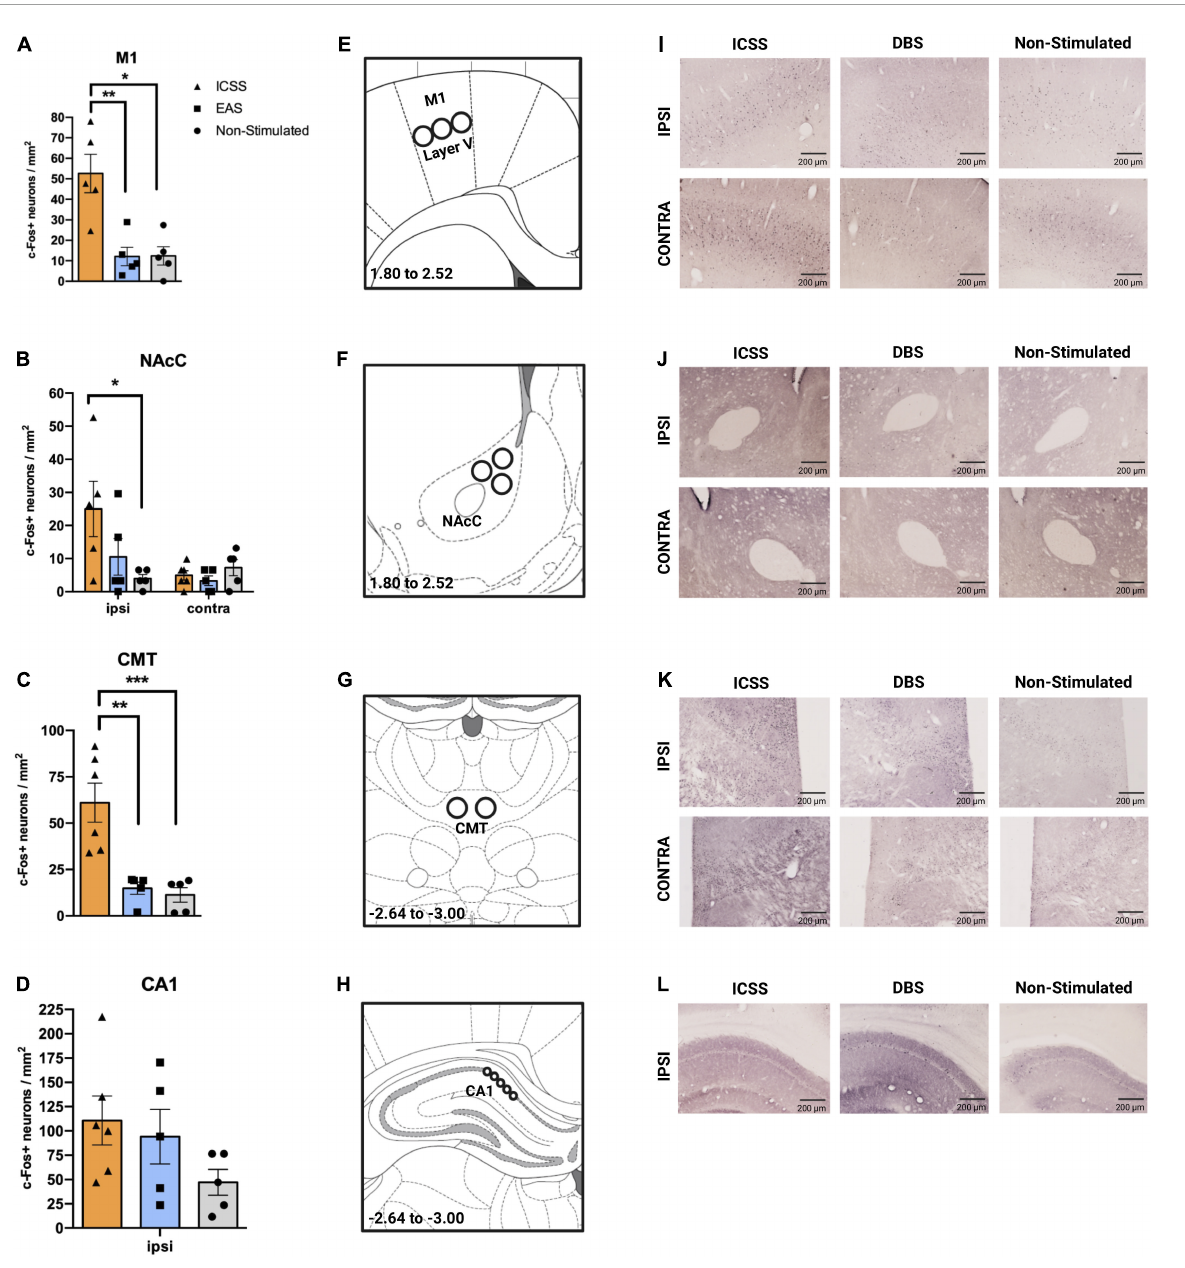
FIGURE10 Effects of different administrations (self-administered or experimenter-administered) on c-Fos expression in the primary motor cortex, nucleus accumbens core, centromedial thalamus, and CA1. (A–D) c-Fos + neurons/mm 2 ( ± SE) in the (A) primary motor cortex (M1), (B) NAcC, (C) CMT, and (D) CA1. The ipsilateral hemisphere corresponds to the right hemisphere, in which the electrode was implanted. Panels (A,C) show the mean expression of c-Fos of both hemispheres. (E–H) Regions of interest (ROI) for the quantification of c-Fos + neurons of the (E) M1, (F) nucleus accumbens core (NAcC), (G) centromedial thalamus, and (H) the cornus ammonis 1 (CA1), with their corresponding coordinates regarding Bregma. Images adapted from Paxinos and Watson (2007). In regions in which HEMISPHERE factor was not significant, the mean of both hemispheres is represented (A,C) . Significant differences are shown as * P ≤ 0.05, ** P ≤ 0.01. (I–L) Representative images of c-Fos expression for each group and area studied taking into account the ipsilateral and contralateral hemispheres. *** P < 0.001.